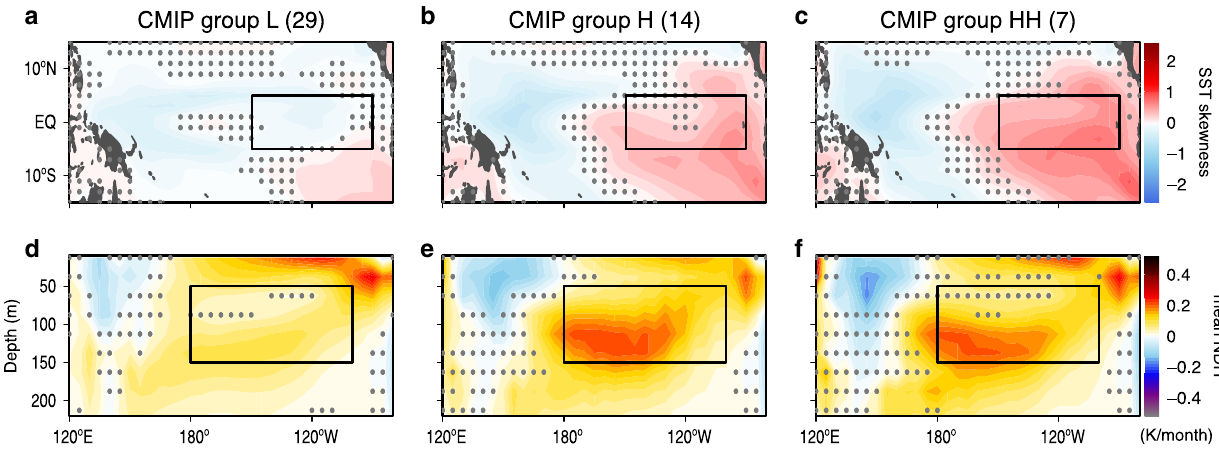
Fig. 3 Simulated SST skewness and equatorial mean NDH. Composite structures of ( a – c ) the skewness of the sea surface temperature (SST) anomaly and ( d – f ) the long-term mean of nonlinear dynamical heating (NDH; K month − 1 ) in the historical simulations for each model group. Dots indicate the shading values that are not statistically signi fi cant at the 95% con fi dence level. Boxes represent the Niño-3 region in a – c while the averaging regions of NDH in ( d – f ).